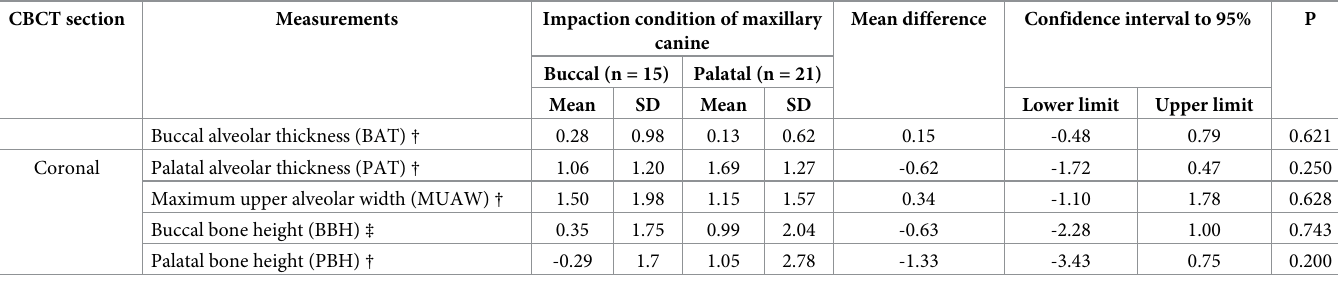
Table 5. Comparison of alveolar bone changes (T0-T1) of PAMIC between buccal and palatal MIC groups. CBCT section